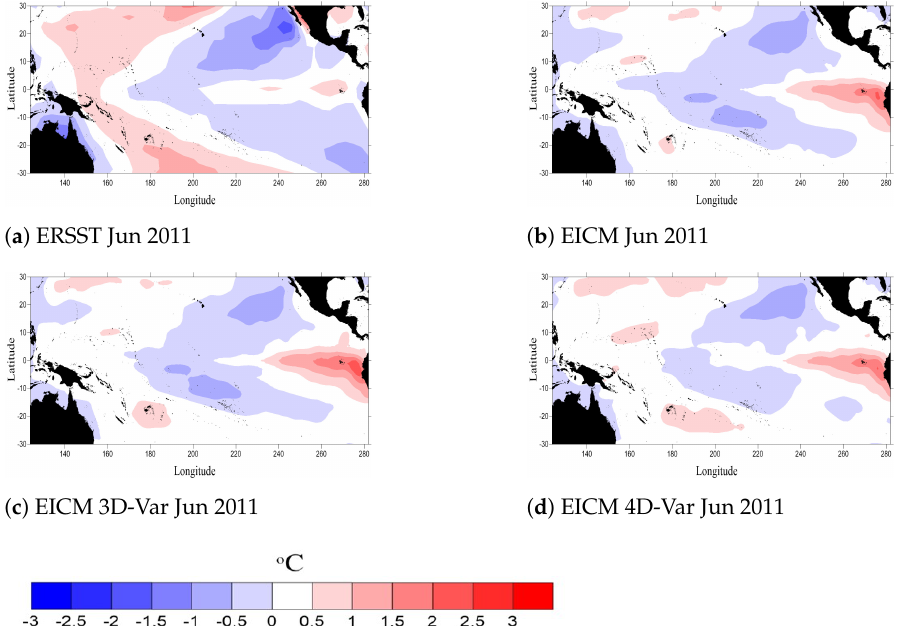
Figure 5. Pacific region SSTA values ( ◦ C) in June 2011 from ERSST measurements ( a ), and the SSTA prediction results at one-month lead time of EICM ( b ), EICM 3D-Var ( c ), and EICM 4D-Var ( d